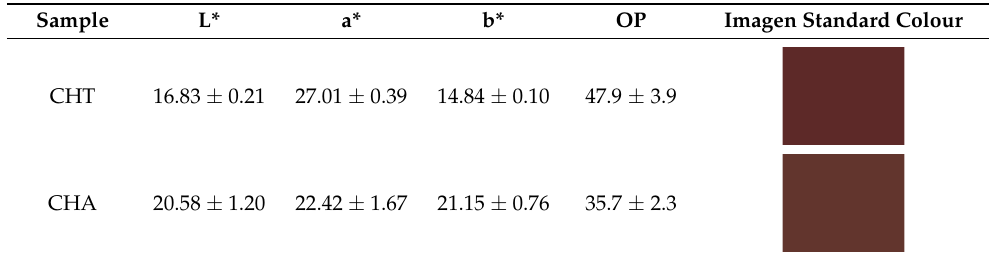
Table 5. CieLab data of the chañar films.